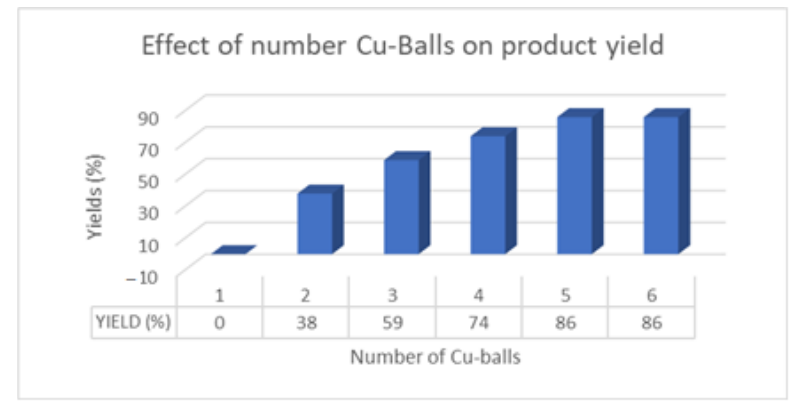
Figure 1. Effect of cylindrical Cu beads (0.27/0.27”) on the product